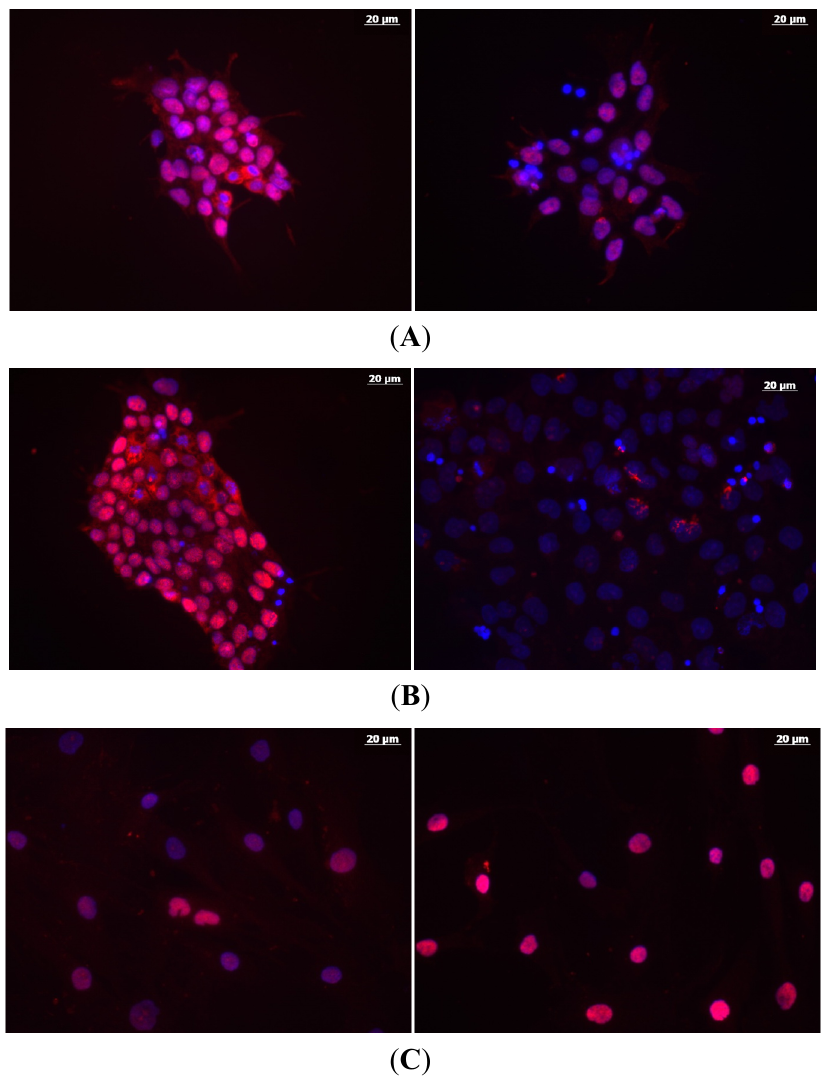
Figure 6. Changes in abundance of p21 protein analyzed in different types of human stem cells after 1 Gy of IR exposures. Shown below are the immunocytochemistry data for cell cultures post treatments (red, p21; blue, nuclei, DAPI staining); left column, sham-IR; right column, 1 Gy. ( A ) H9 hESCs, 4 h post IR; ( B ) H9 hESCs, 24 h post IR; ( C ) hMSCs, 4 h. Bar is 20